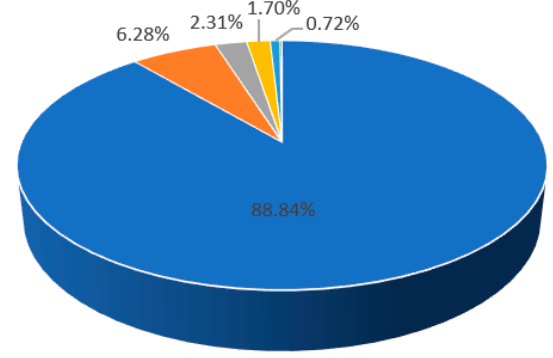
Figure 1. Proportion diagram for different pipe materials.